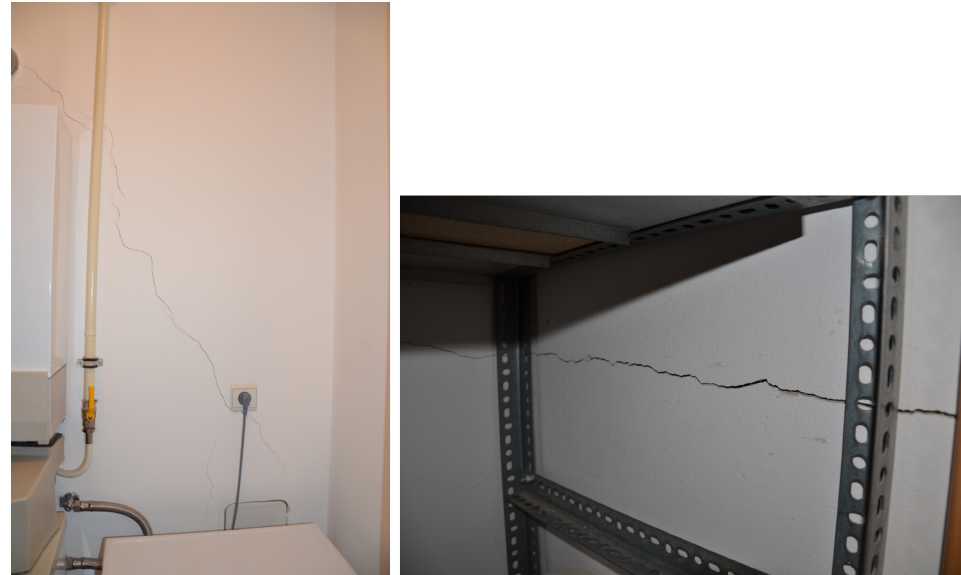
Figure 1. Cracks in partition walls.